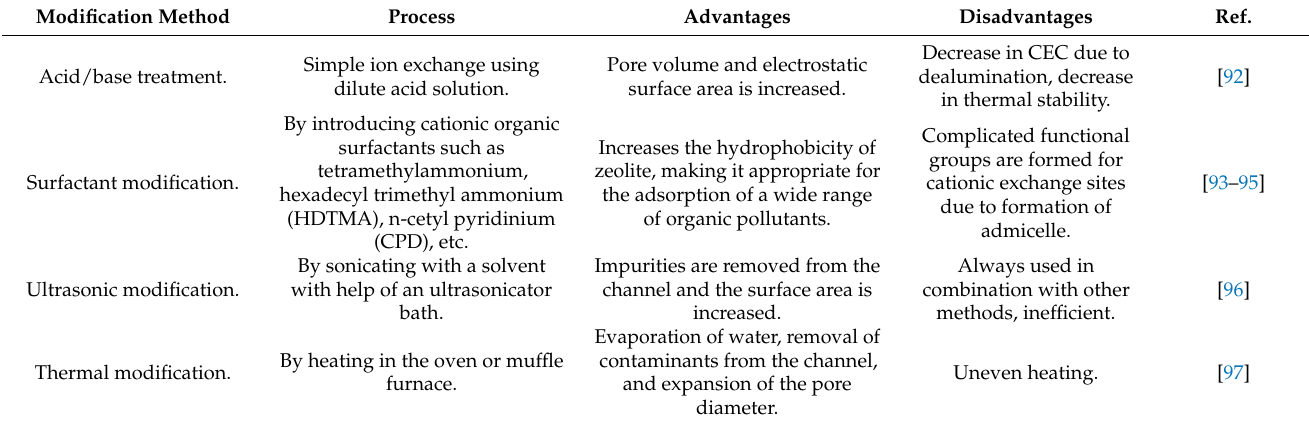
Table 6. Modification of zeolites, their advantages and disadvantages. Reprinted from Ref.